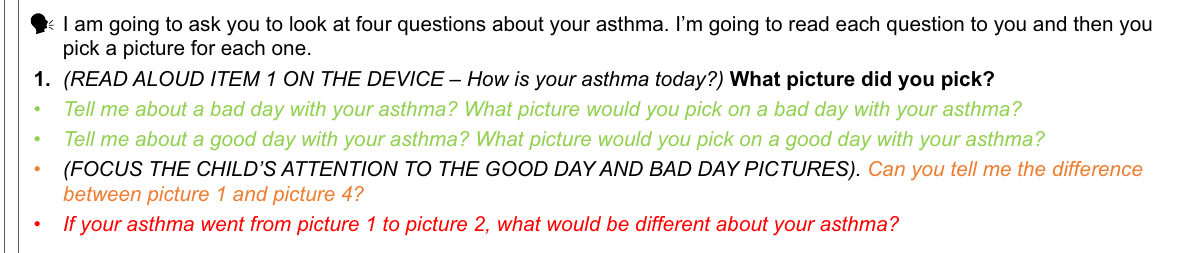
Fig. 3 Example of traffic light system questioning from the interview